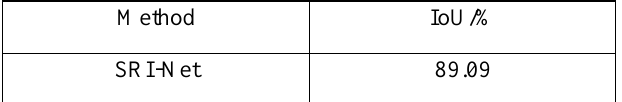
Table 3. Accuracy comparison of the state-of-the-art methods for building